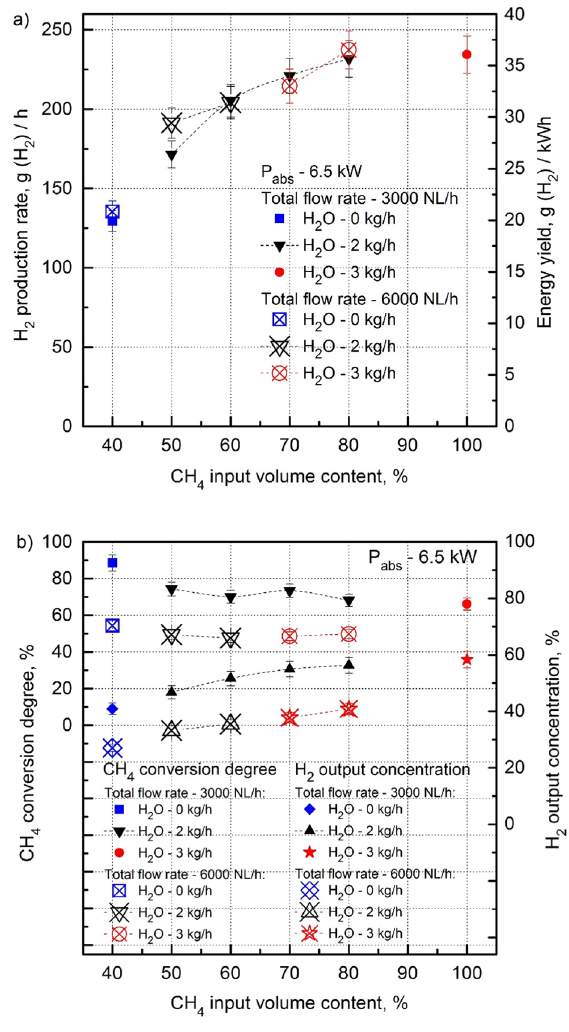
Figure 8. H 2 production rate, energy yield ( a ), CH 4 conversion degree and H 2 output concentration ( b ) as a function of the CH 4 input volume content (%) in the CH 4 :CO 2 mixture for a recommended total flow rate of 3000 NL/h and, for comparison, for 6000 NL/h (P abs —6.5 kW). The applied H 2 O steam consumption rates ensure stable operation of the MPS at a given CH 4 input volume